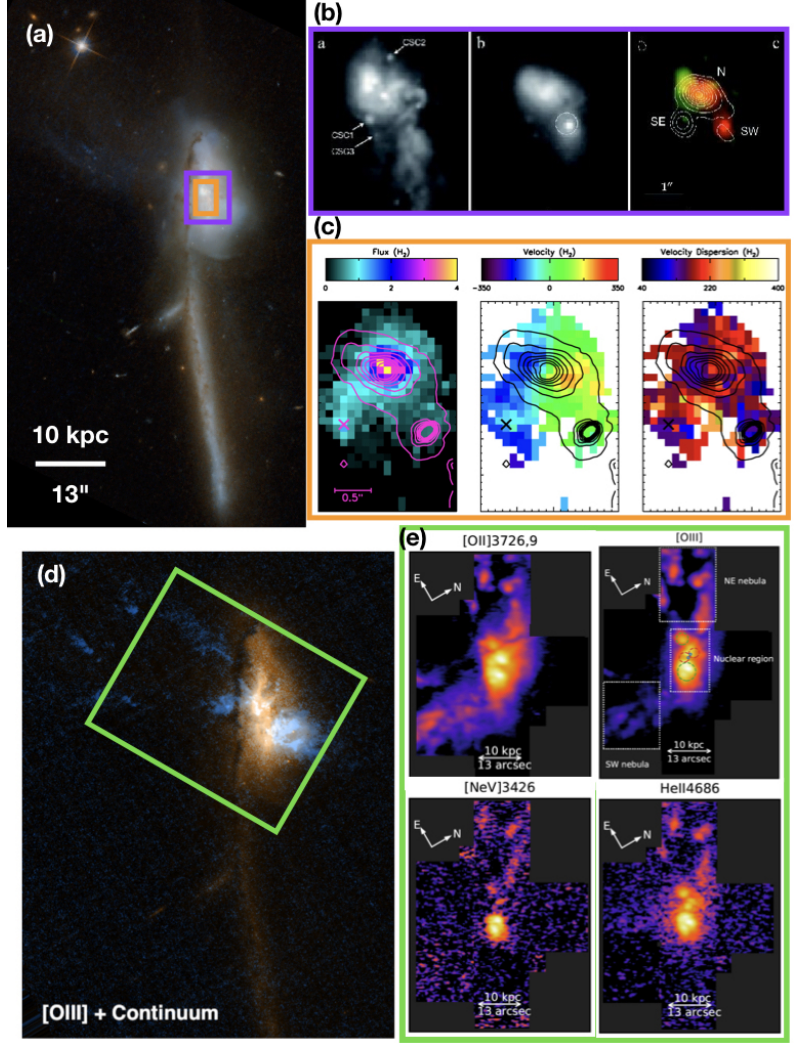
Figure 11. ( a ) Mrk 273 as seen in visible light from HST /ACS F435W and F814W imaging; north points up and a 10 kpc ( ∼ 13 (cid:48)(cid:48) ) scale bar is shown. Purple and orange boxes correspond to in- sets ( b , c ), respectively; ( b ) from left to right: ( a ) HST /ACS F814W , ( b ) HST /NICMOS F160W , and ( c ) composite of the previous two overlaid with the VLA 8.4 GHz image [142] in contours, figure adapted from Iwasawa et al. [108], reproduced with permission from © ESO; ( c ) from left to right: flux, velocity, and velocity dispersion of the H 2 1 − 0 S(1) overlaid with the K band continuum as observed with Keck OSIRIS, figure from U et al. [109]; ( d ) HST /ACS continuum (red) + [O III ] (blue) from Rodríguez Zaurín et al. [211], reproduced with permission from © ESO; green box indi- cates the zoomed-in region for ( e ); ( e ) emission line maps highlighting the extent of ionized